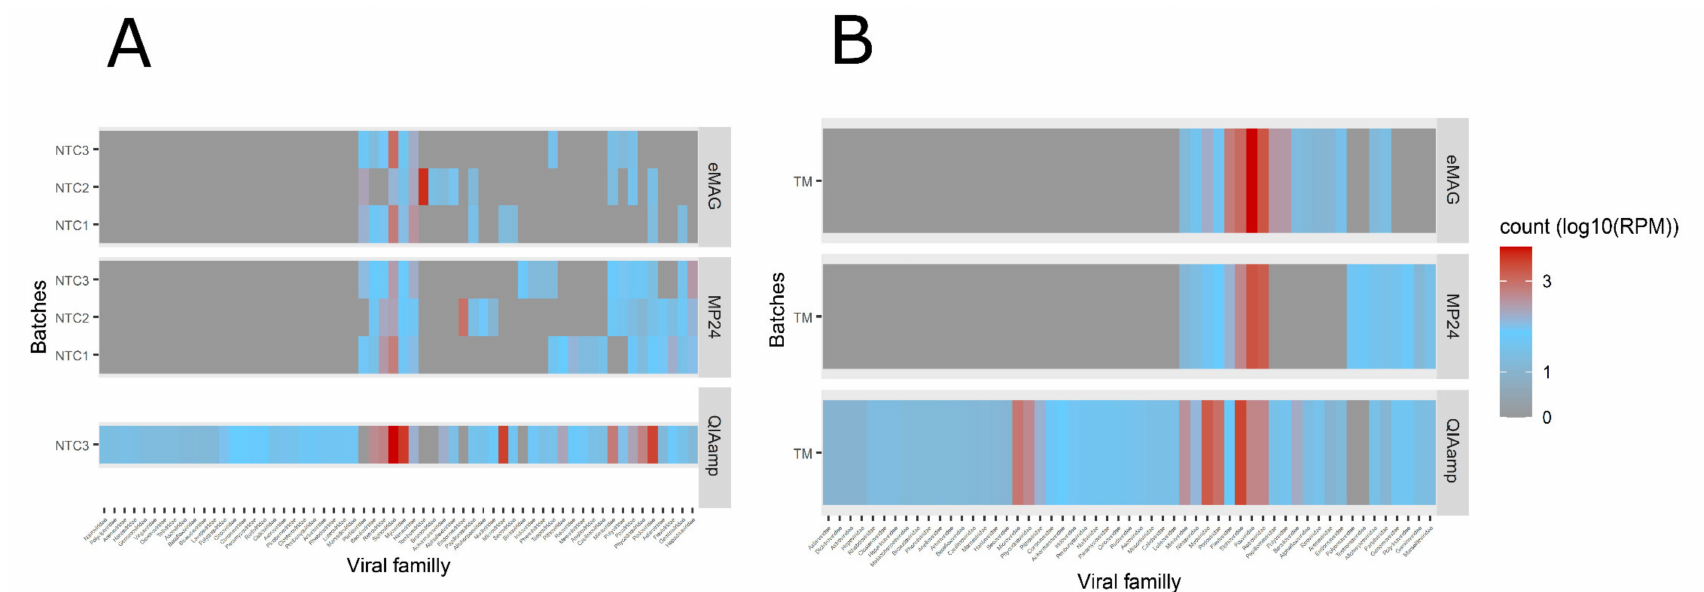
Figure 7. Virus family presence contained ( A ) in NTC and ( B ) in TM (other than the target virus) in each triplicate from the di ff erent extraction methods. The heatmap showed the viral family read count associated with the kitome (the presence of reads associated with other viruses than the targeted viruses) normalized in log 10 (RPM) in each NTC and TM between the di ff erent extraction methods. A gradient of colors was defined from gray (no count) to blue (few counts) to red (highest counts). During the automated extractions, the NTCs were interspersed between samples (i.e., 3 NTCs per batch). For manual extraction, only one NTC was added. In addition to the NTC, transport medium was added. Analyses were performed on the family taxonomical level. A sample was considered to be positive for a particular virus when the log 10 (RPM) of this virus exceeded 1. HSV: herpes simplex virus; RSV: respiratory syncytial virus; NTC: no template control; TM: transport medium; RPM: reads per